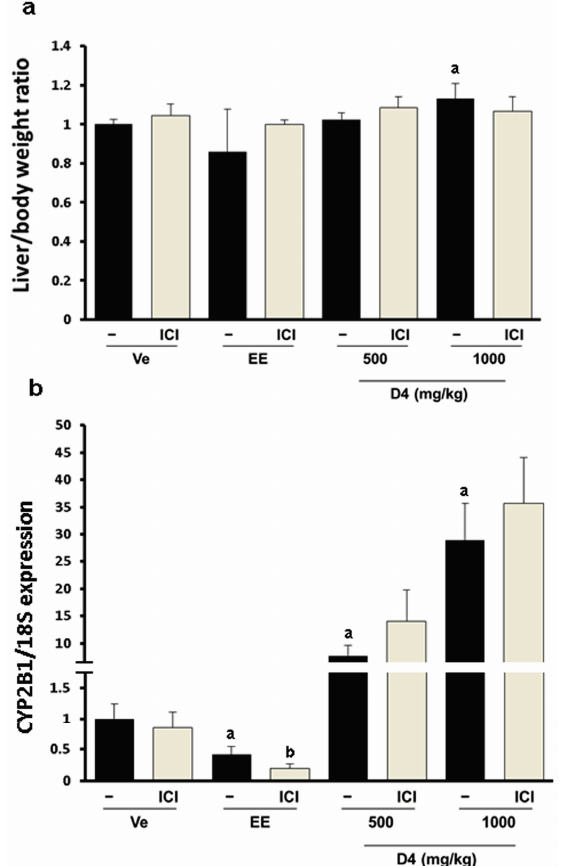
Figure 3. Liver/body weight ratio ( a ); and CYP2B1 mRNA expression ( b ) in